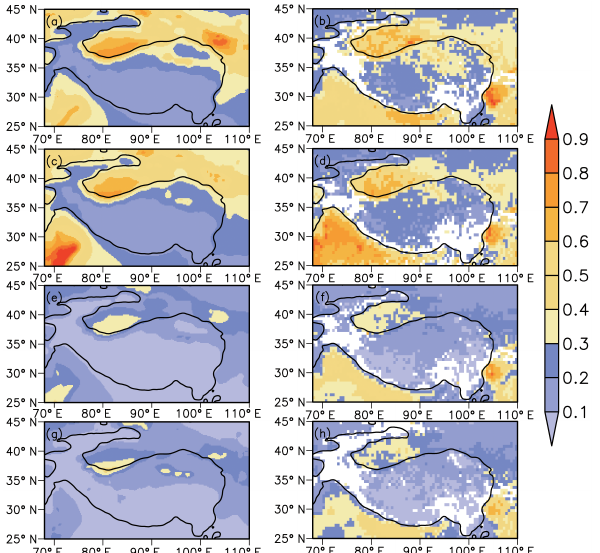
Figure 3. Spatial distribution of the dust AOD simulated by the con- trol experiment (a, c, e, g) and the total AOD observed by MISR at 550nm (b, d, f, h) averaged in (a, b) spring, (c, d) summer, (e, f) au- tumn and (g, h) winter during the time period 2000–2009.